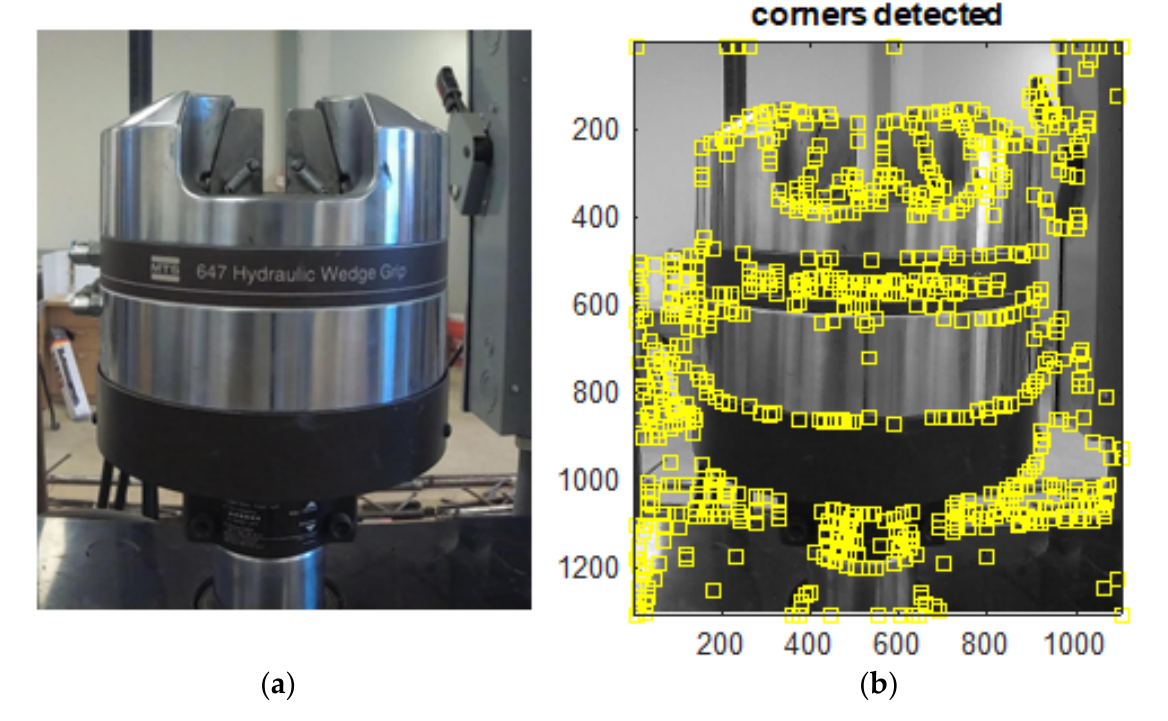
Figure 3. The moving piston of the MTS machine. ( a ) Before feature detection. ( b ) After feature detection.